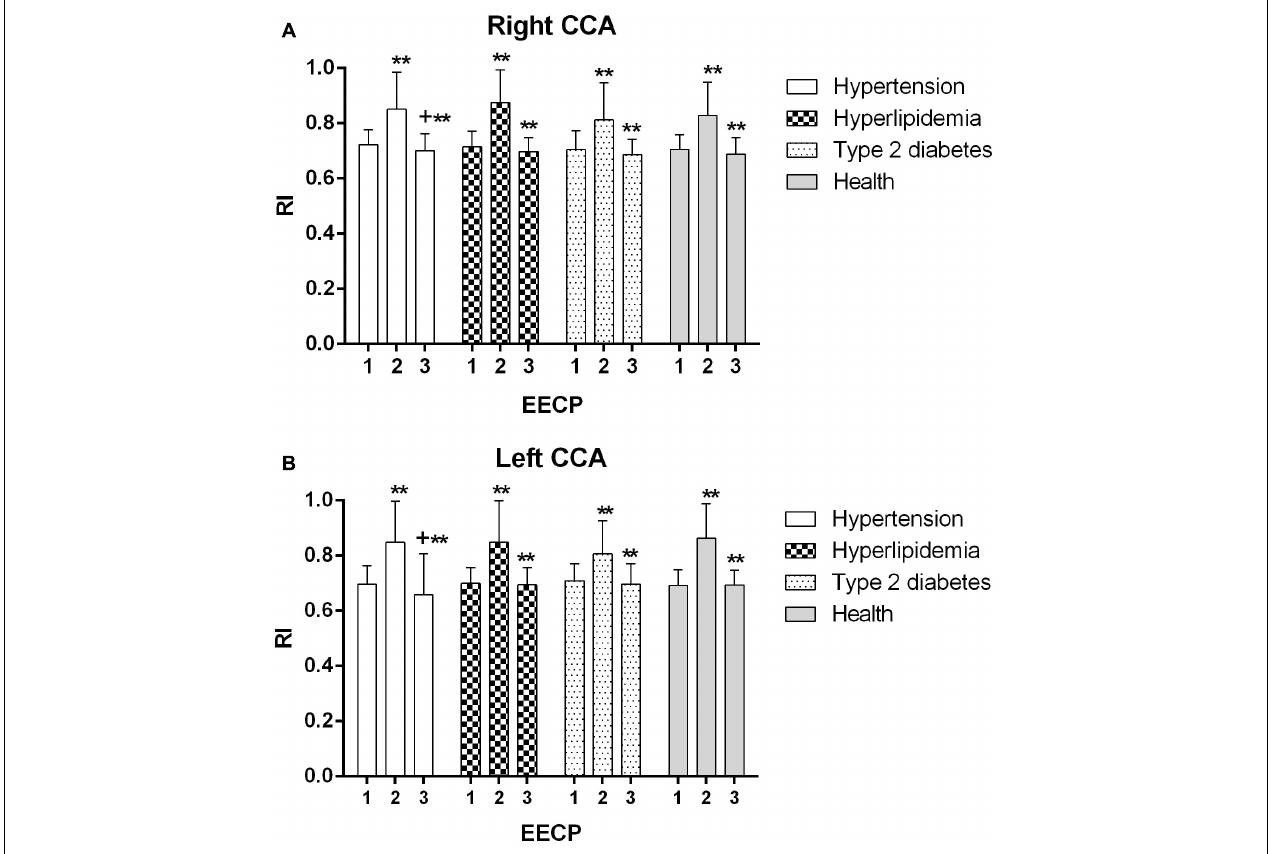
FIGURE 5 | Resistance index (RI) of the right (A) and left (B) common carotid artery (CCA) in four groups before, during and after 45-min EECP. ** P < 0.01 during EECP vs. pre-EECP; + P < 0.05 post-EECP vs. pre-EECP.